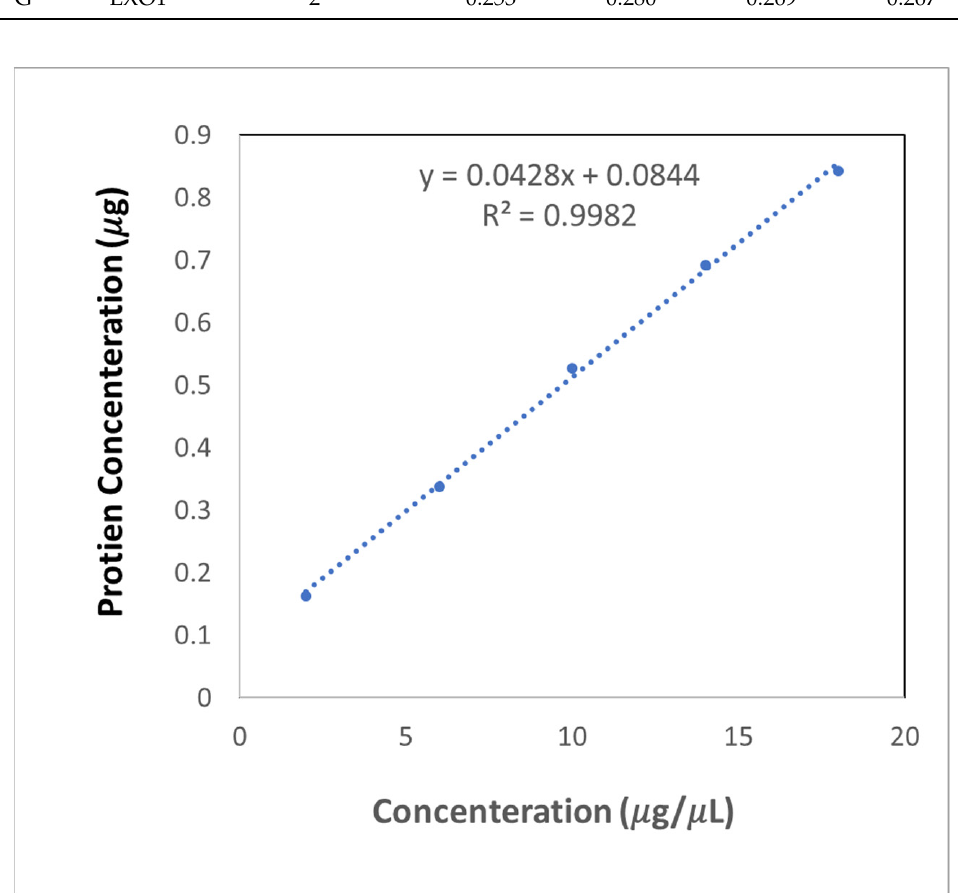
Figure 4. Exosomes Concentration Standard Curve .